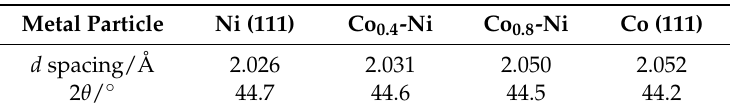
Figure 2. XRD profiles of ( a ) fresh oxygen carriers and ( b ) reduced oxygen carriers.